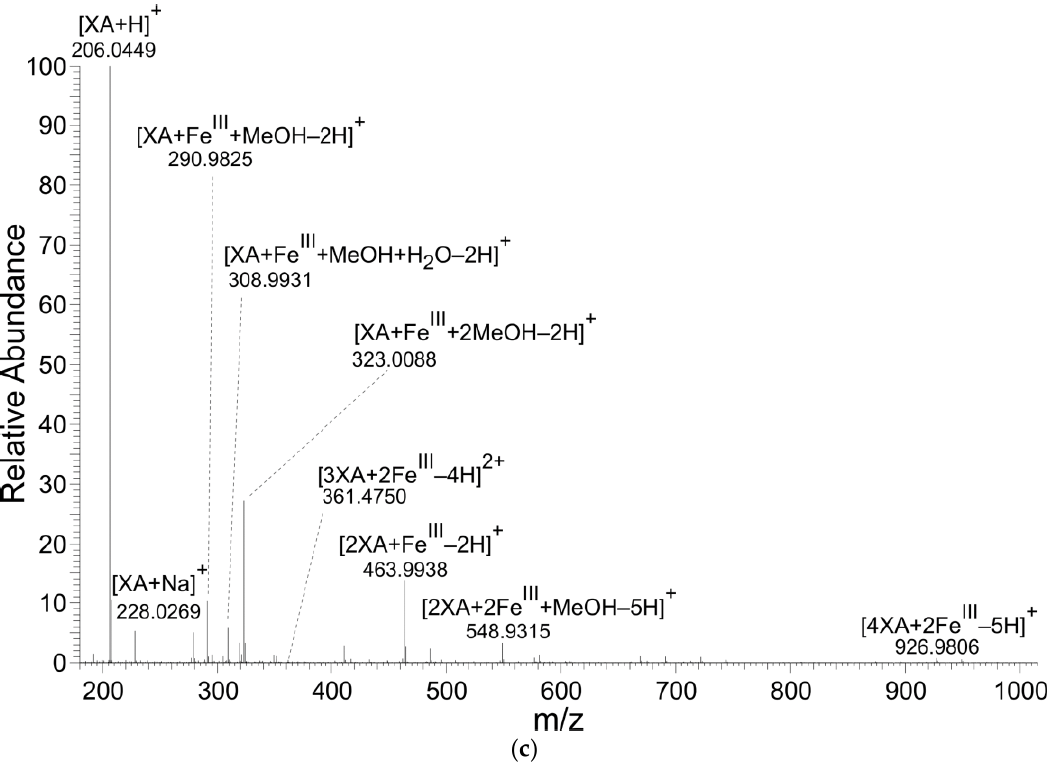
Figure 2. Mass spectra of coordination complexes in solutions of ( a ) Fe II with KYNA, ( b ) Fe II with XA and ( c ) Fe III with XA, detected by nano-ESI‒MS, positive ionization mode. The solutions were prepared by mixing of the KYNA or XA solutions with Fe II or Fe III ions solutions in a molar ratio of metal to ligand of 1:2.